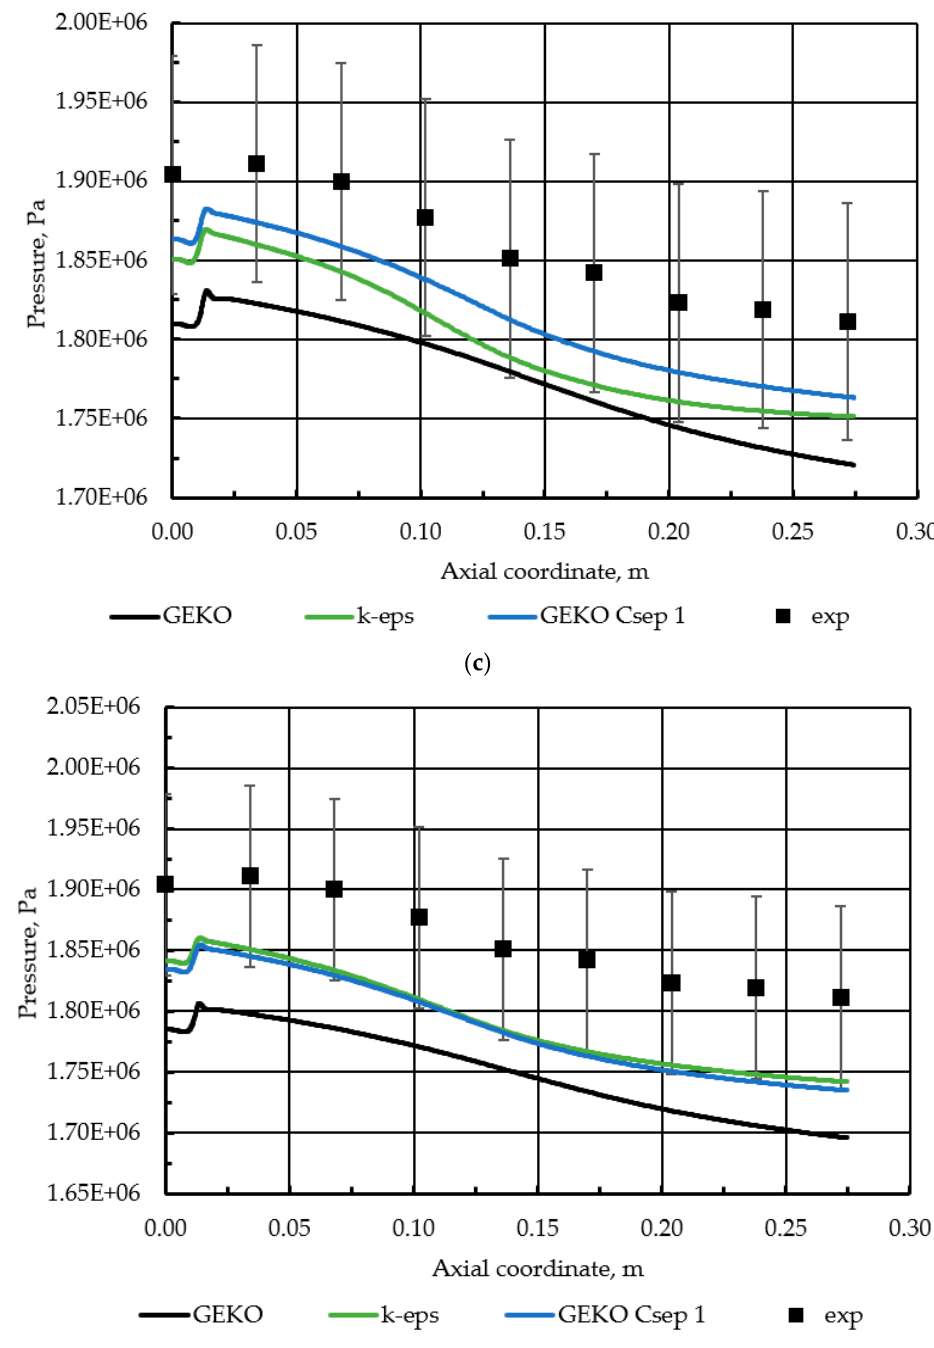
Figure 9. ( a ) Wall heat flux: experiment and simulations for Zhukov–Kong kinetic mechanism; ( b ) Wall heat flux: experiment and simulations for RAMEC kinetic mechanism; ( c ) Pressure: experiment and simulations for Zhukov–Kong kinetic mechanism; ( d ) Pressure: experiment and simulations for RAMEC kinetic mechanism.